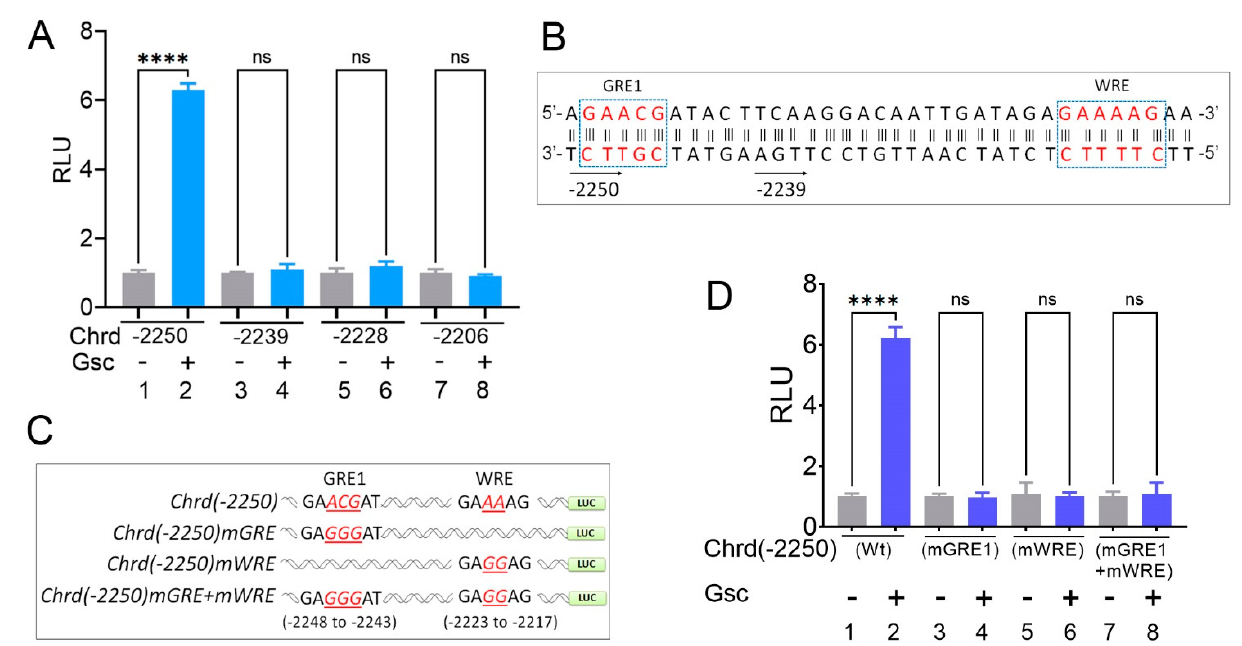
Figure 4. Site-directed mutagenesis of GRE1 and WRE within the chrd promoter completely abolishes Gsc-mediated transcriptional activation. ( A ) Relative luciferase activity of serially deleted chrd promoter constructs with or without Gsc. ( B ) Chrd promoter (-2250 to -2214 bps)with highlighted GRE1 and WRE (dotted boxes). The bottom arrowhead indicates the sequences of chrd(-2250) and chrd(-2239) reporter constructs. ( C ) Schematic representation of the site-directed mutagenesis scheme; targeted nucleotides are shown in italics and red. ( D ) Relative luciferase activity of chrd(-2250)mGRE1 and chrd(-2250)mWRE constructs with or without Gsc. **** p ≤ 0.0001, and n.s. denotes nonsignificant values.